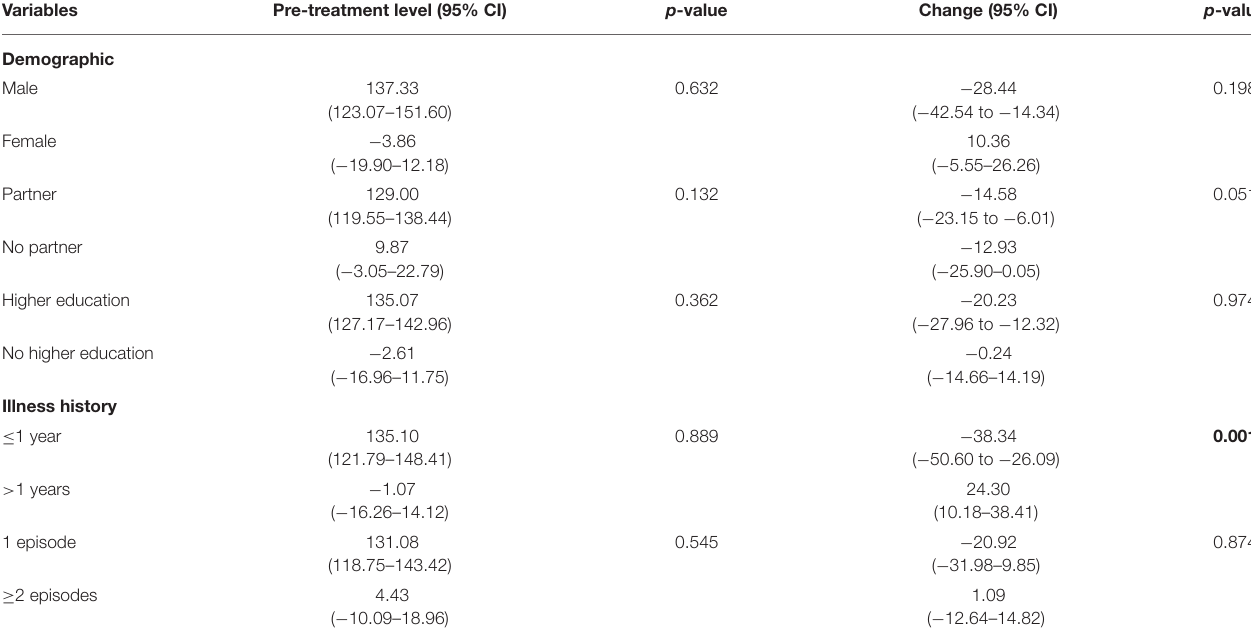
TABLE 2 | Linear mixed model with estimated pre-treatment level and change in residual cognitive symptoms (BRIEF-A GEC) adjusted for categorical demographic, illness history, and therapy process variables ( N =